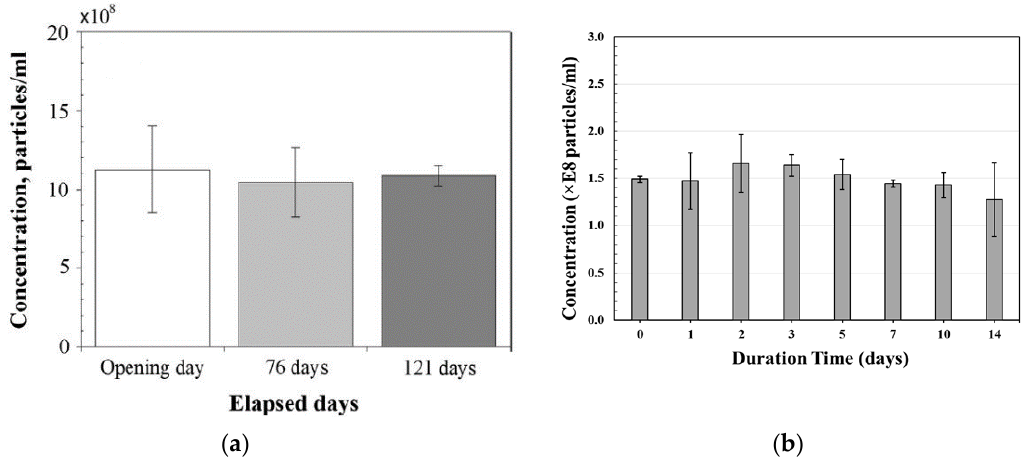
Figure 3. Average particle concentration of nanobubbles: ( a ) concentration of nanobubbles in gasoline [15]; ( b ) concentration of nanobubbles [16].